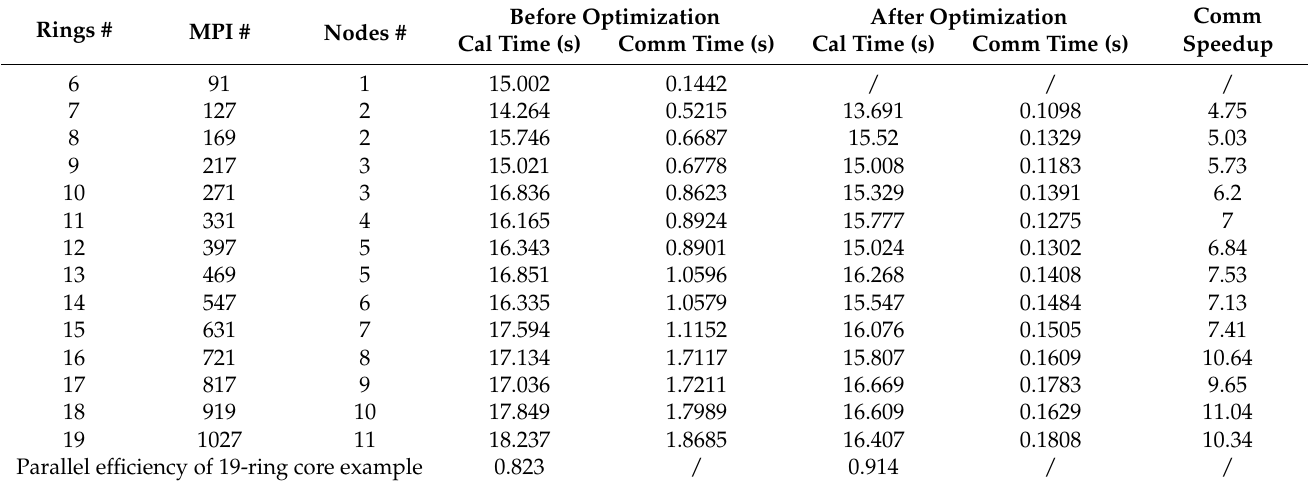
Table 5. Optimization performance on Platform 1 (96 cores per node).